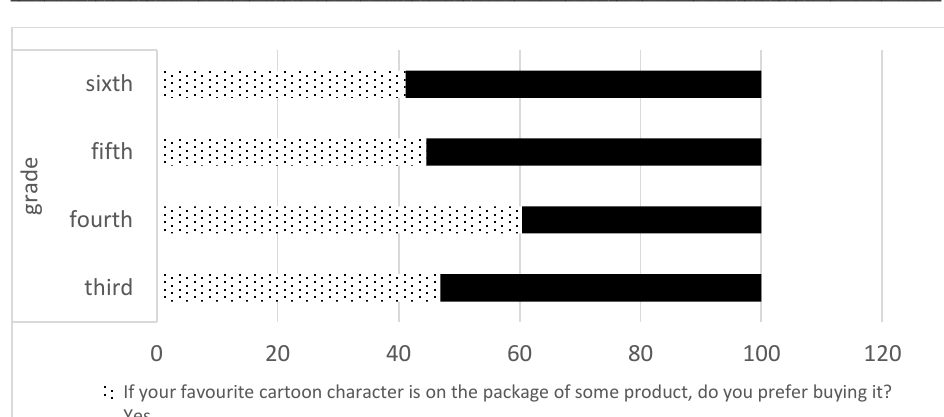
Figure 4. The preference of pupils across various grades to purchase the product if a favourite cartoon character is on the packaging of one of the products. (per grade - legend: third grade - nine years, fourth grade - ten years, fifth grade - eleven years and sixth grade - twelve years old child). Source: the authors'